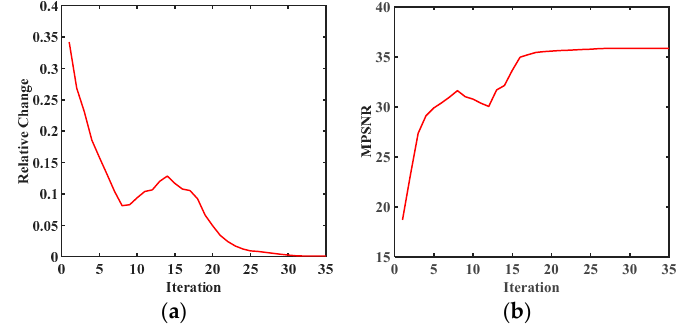
Figure 13. Convergence analysis with the iteration number: ( a ) relative changes (cid:107)X k + 1 − X k (cid:107) F / (cid:107)X k (cid:107) F and ( b ) MPSNR versus the iteration number in the simulated Indian Pines dataset.